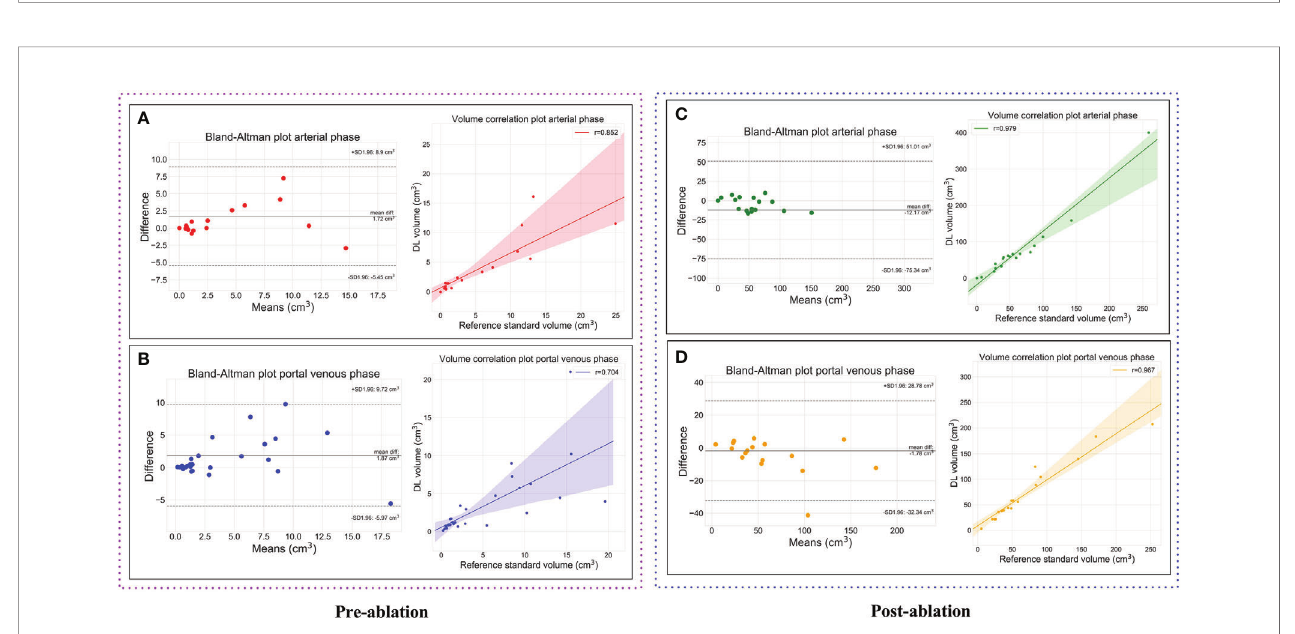
FIGURE 5 | Plots showing the volumetric assessment between the reference standard and the automatic deep learning based segmentations. Lesions on pre- ablation arterial phase (A) , portal venous phase (B) and, ablation zones on the post-ablation arterial phase (C) , portal venous phase (D)